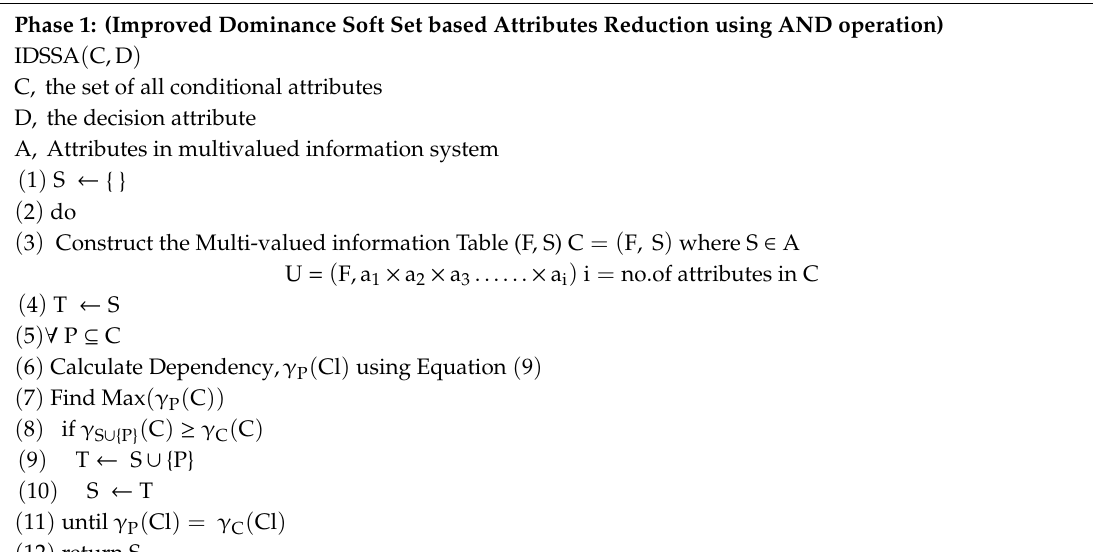
Algorithm 2 Improved dominance soft set-based attributes reduction using AND operation